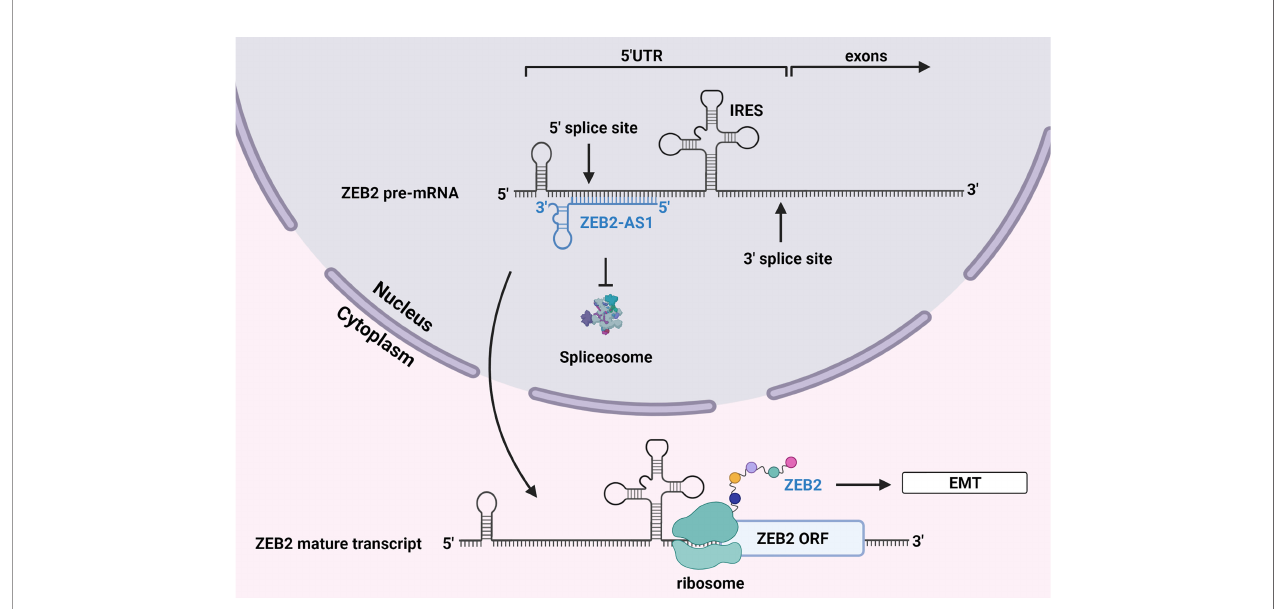
FIGURE 3 | Alternative splicing by lncRNA ZEB2-AS1. The antisense lncRNA ZEB2-AS1 binds to the 5 ’ UTR donor splice site of mRNA encoding ZEB2, a transcriptional repressor of E-cadherin. This prevents the spliceosome from eliminating this region of the transcript, which contains an IRES that is necessary for translation. ZEB2 is subsequently translated, and its increased levels promote EMT. Created with